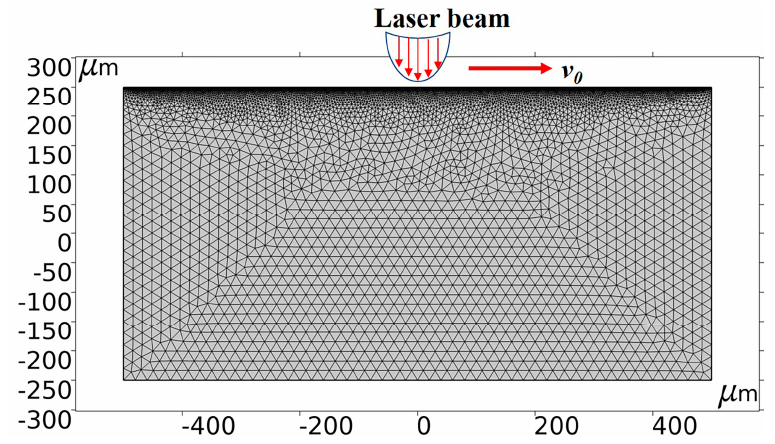
Figure 1. Mesh division image.